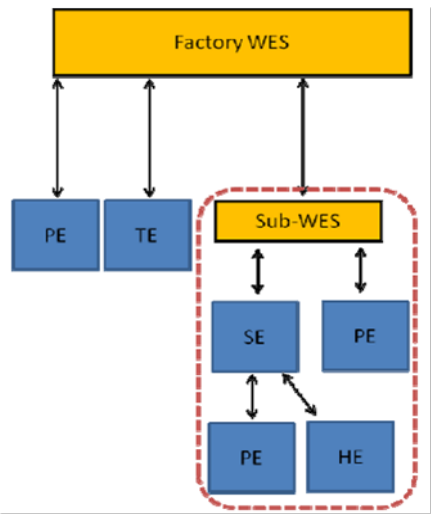
Figure 3. Distributed